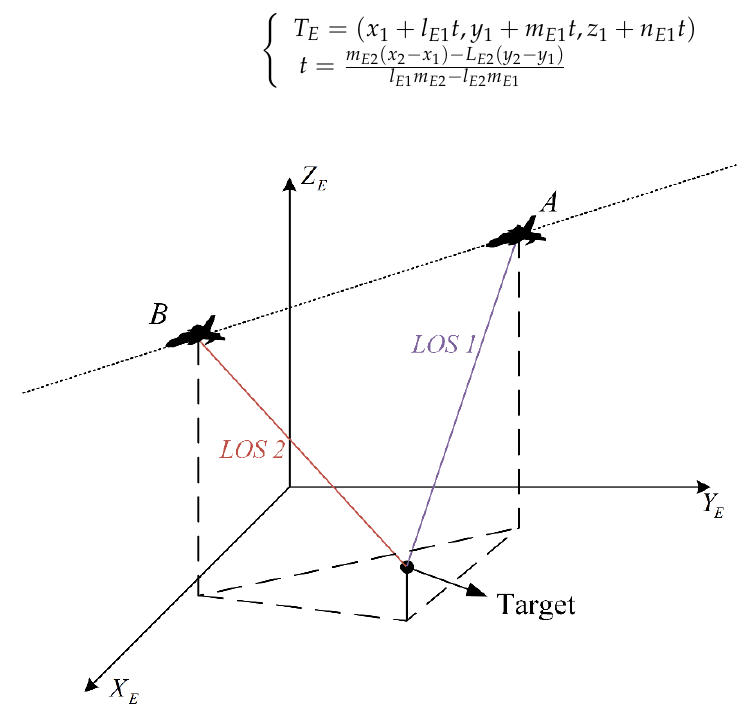
Figure 11. Two-point intersection positioning model.